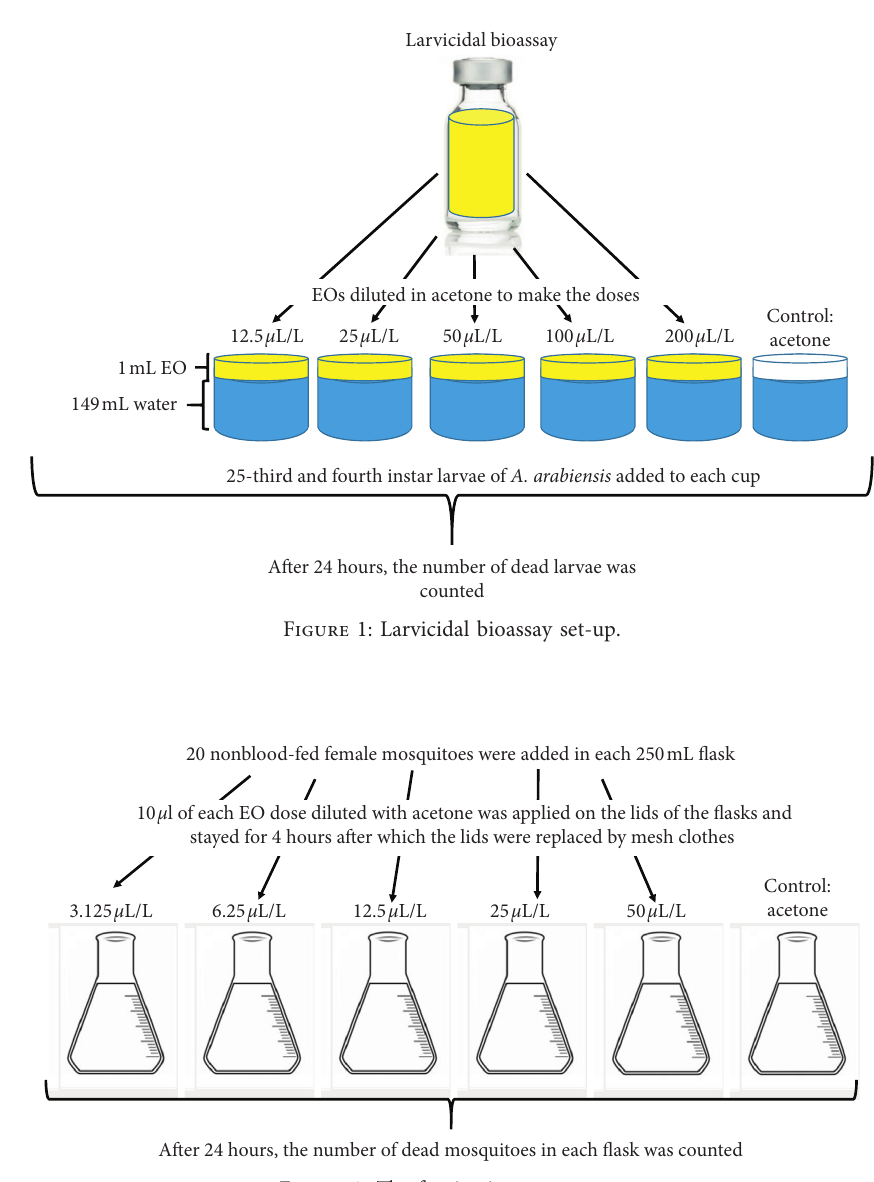
Figure 2: The fumigation test set-up.